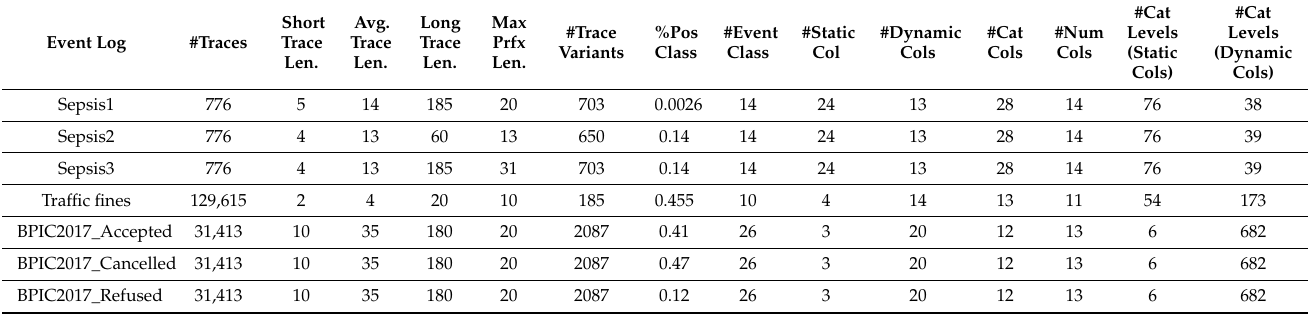
Table 1. Event logs